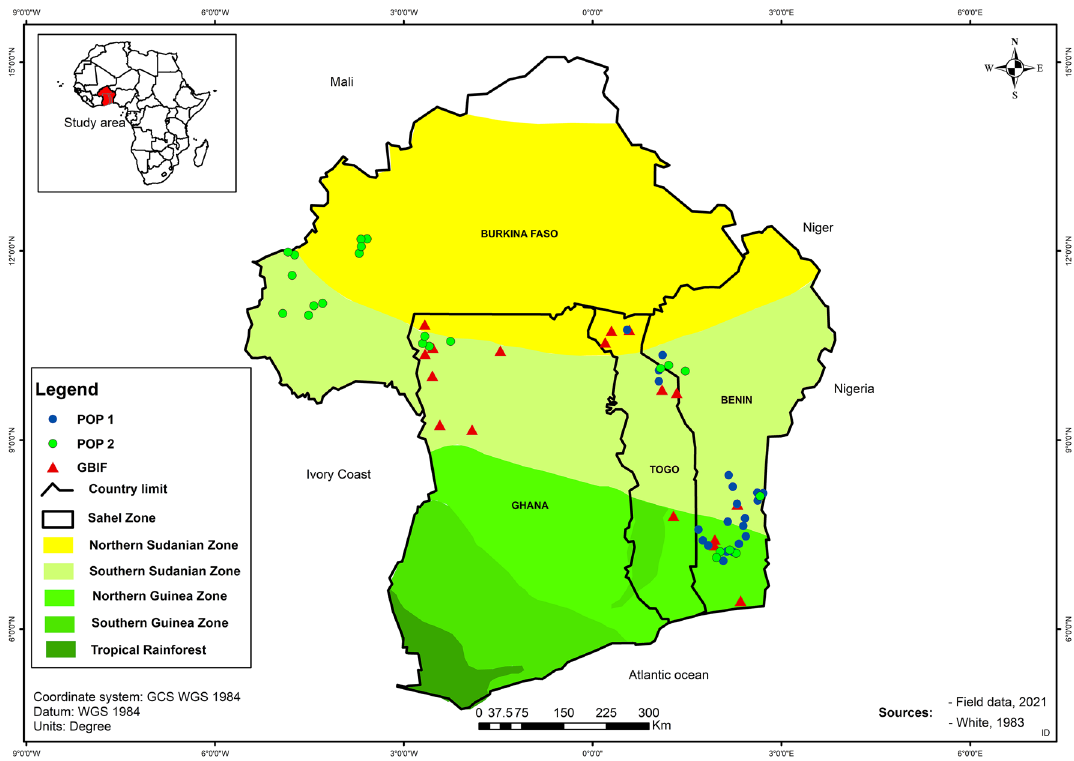
Figure 3. Map showing the distribution of Kersting’s groundnut across agroecological zones of Burkina Faso, Benin, Ghana, and Togo: species collections points (circles) and the locations points downloaded from GBIF (triangles) used in the ecological niche modeling. Genetic groups are depicted by the blue (Pop1) and green (Pop2) colours. Software used: ArcGIS v.